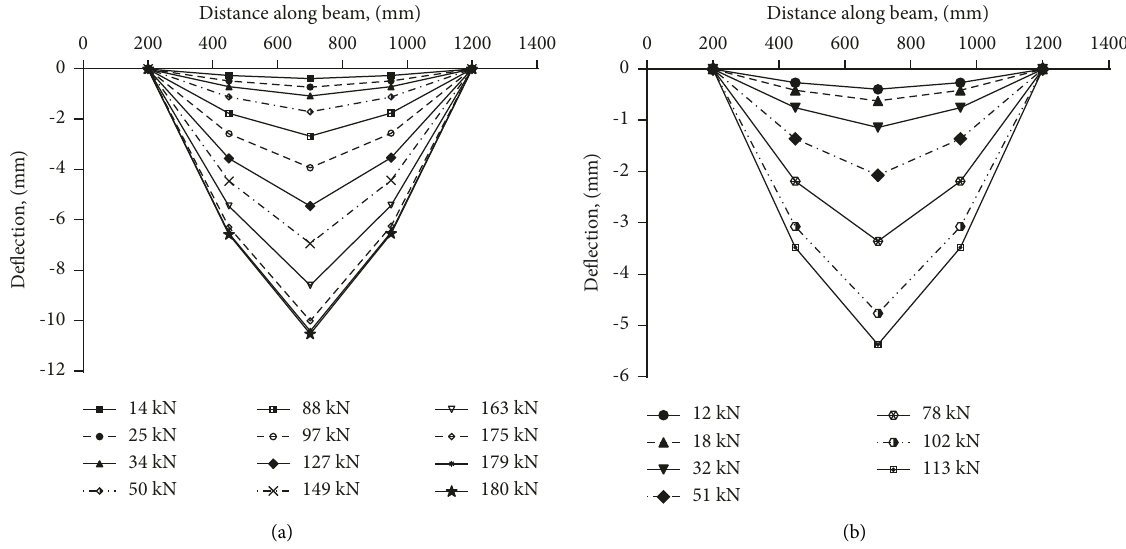
Figure 17: History of deflections throughout loading steps from start to failure. (a) A2.5RC10/10. (b)